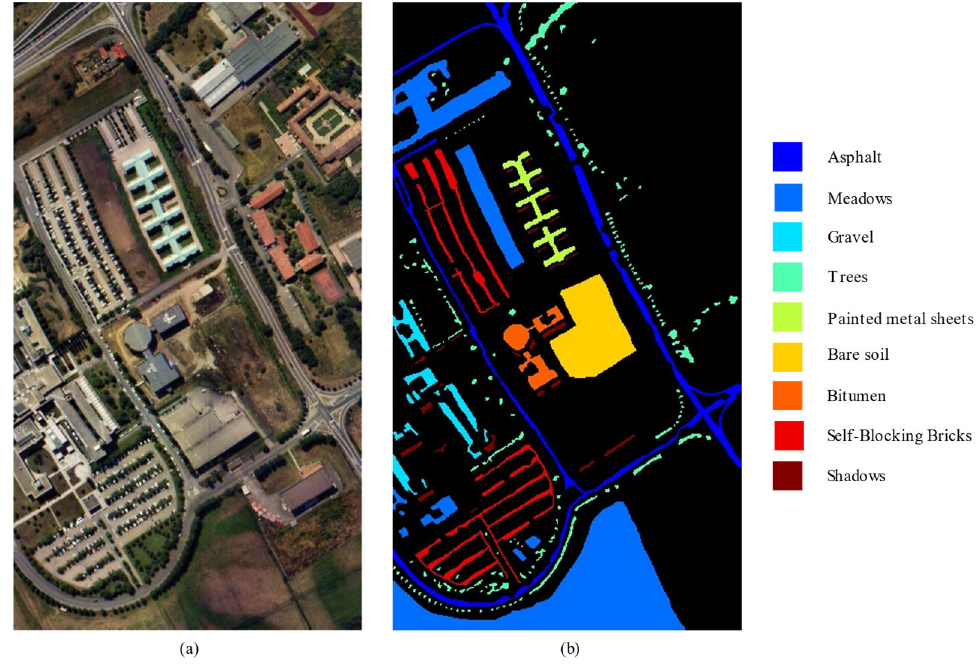
Figure 5. Pavia University dataset. ( a ) Pseudocolor image; ( b ) ground truth.